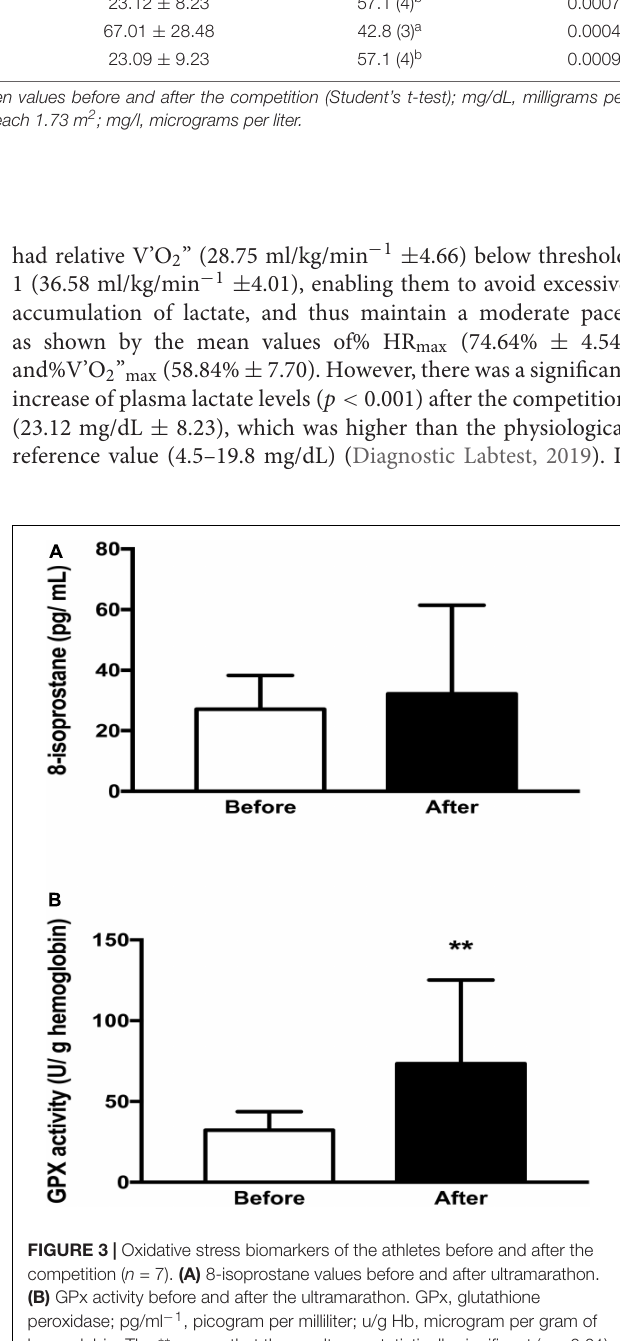
TABLE 4 | Blood and urine biomarkers of the athletes before and after the competition ( n = 7). Biomarker Before After Mean ± SD % of individuals with Mean ± SD % of individuals with P -value altered values (n) altered values (n) Glucose (mg/dL)